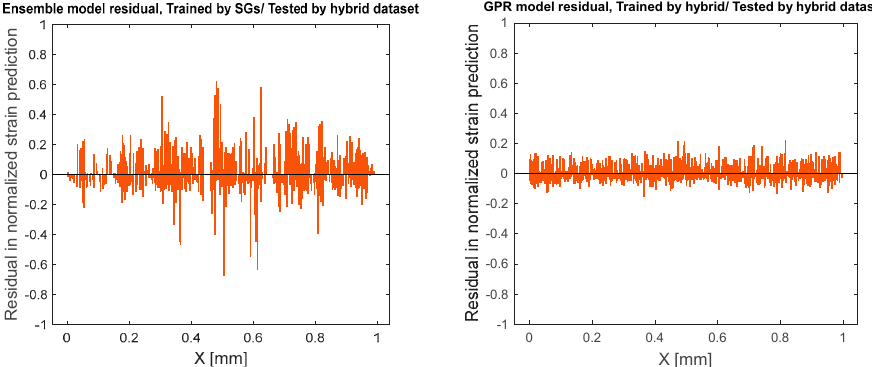
Figure 17. Obtained residuals in normalized strain predictions in the hybrid test dataset.